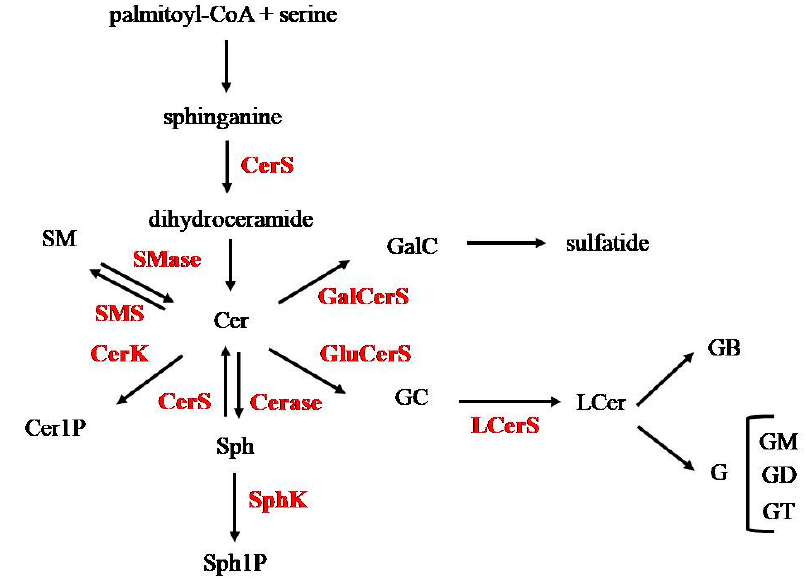
Figure 2. Ceramide production and utilization. In yellow, simple sphingolipids (SphLs); in green, glycosphingolipids (GSLs); in red, enzymes. Description in the